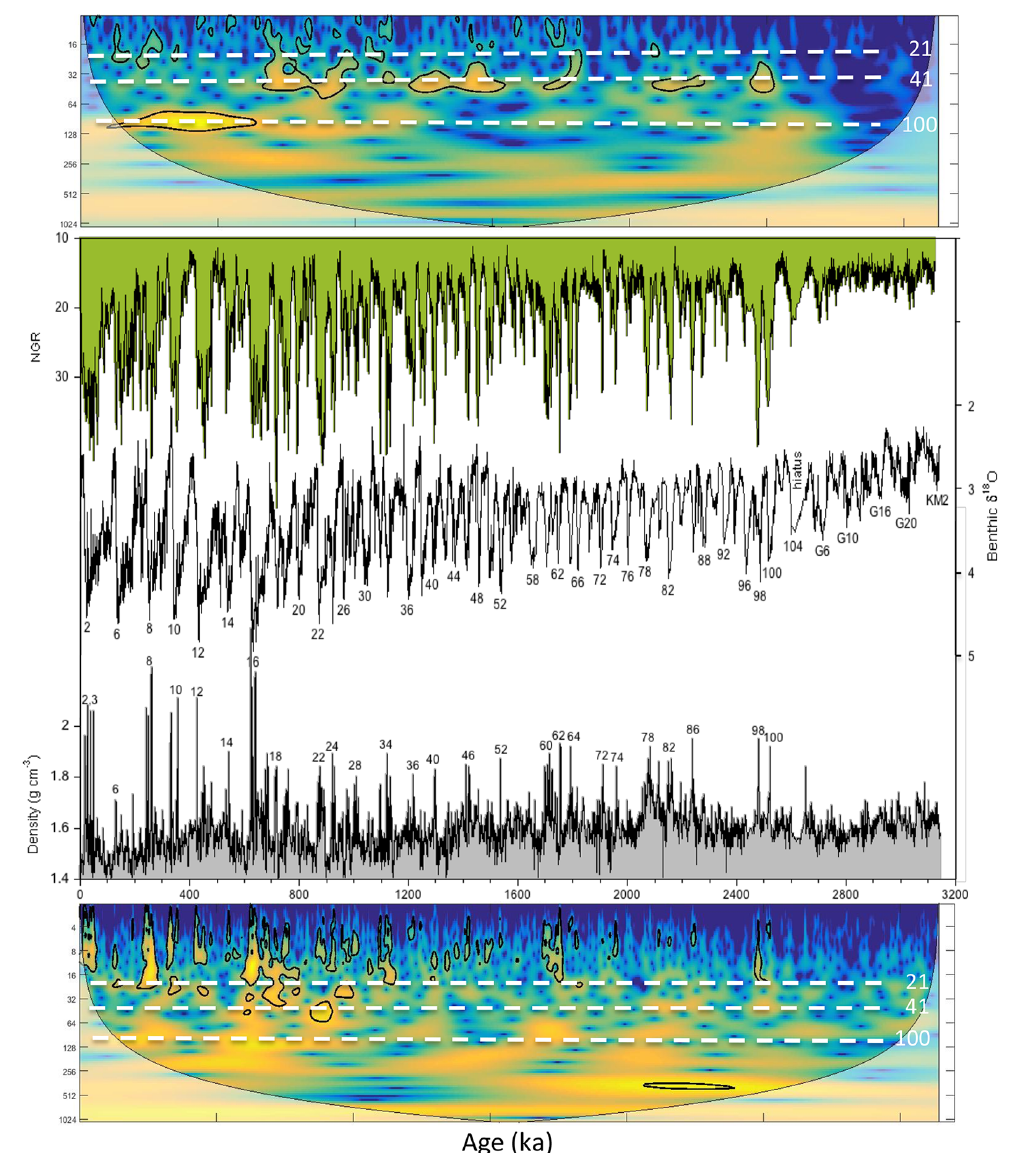
Figure 7. Natural gamma radiation (NGR; green) and density (gray) relative to the benthic δ 18 O record of Site U1308. Prominent marine isotope stages are labeled. Top and bottom panels are continuous wavelet transform of the NGR and density records of Site U1308, respec- tively. Black contours on the wavelet plots indicates the 5% significance level against red noise. The horizontal dashed white lines represent the orbital periods of precession ( ∼ 21kyr), obliquity ( ∼ 41kyr), and eccentricity ( ∼ 100kyr).